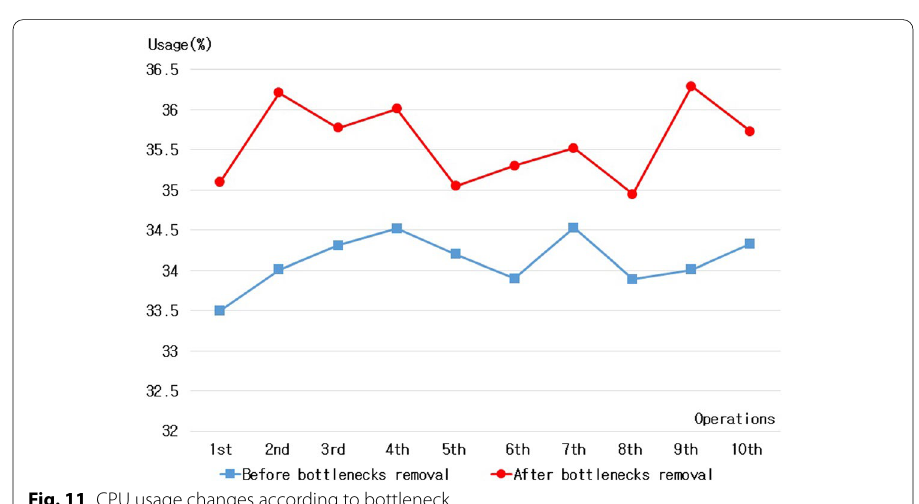
Fig. 11 CPU usage changes according to